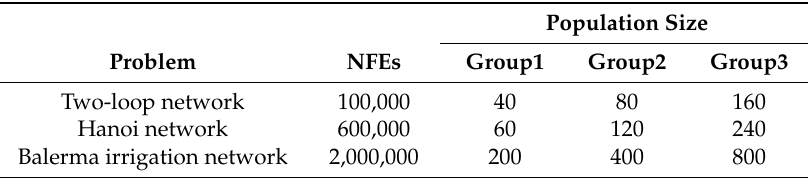
Table 3. Implementation features.